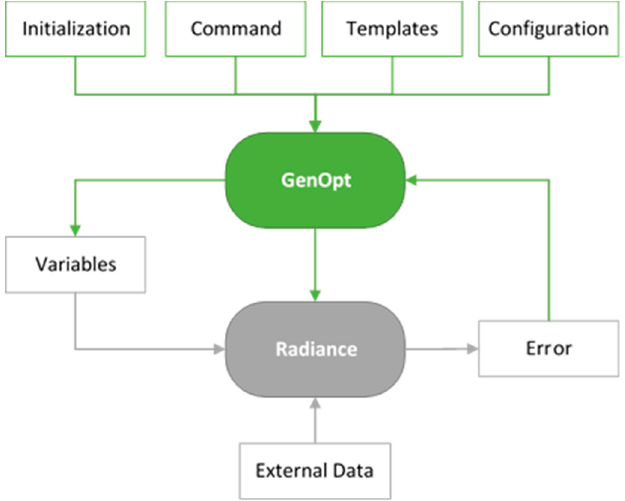
Figure 2. Calibration methodology applied to the simulation of outdoor lighting installations.